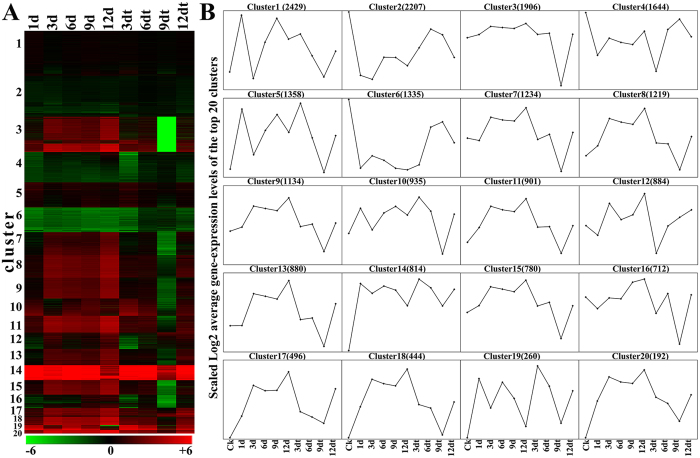
Clustering of the transcriptome response to ethephon.(A) Heatmap showing 21,764 unigenes expression clusters generated by the clustering affinity search technique method. Each line refers to data of one gene. The order is from the cluster with the most members (2,429 genes) to that with the least members (192). The color bar represents the log2 of FPKM values, ranging from green (−6), black (0) to red (6.0). (B) Log2 average gene-expression levels of the top 20 clusters. The number of cluster members with the number of associated unigenes in parentheses was on the top of the plot.